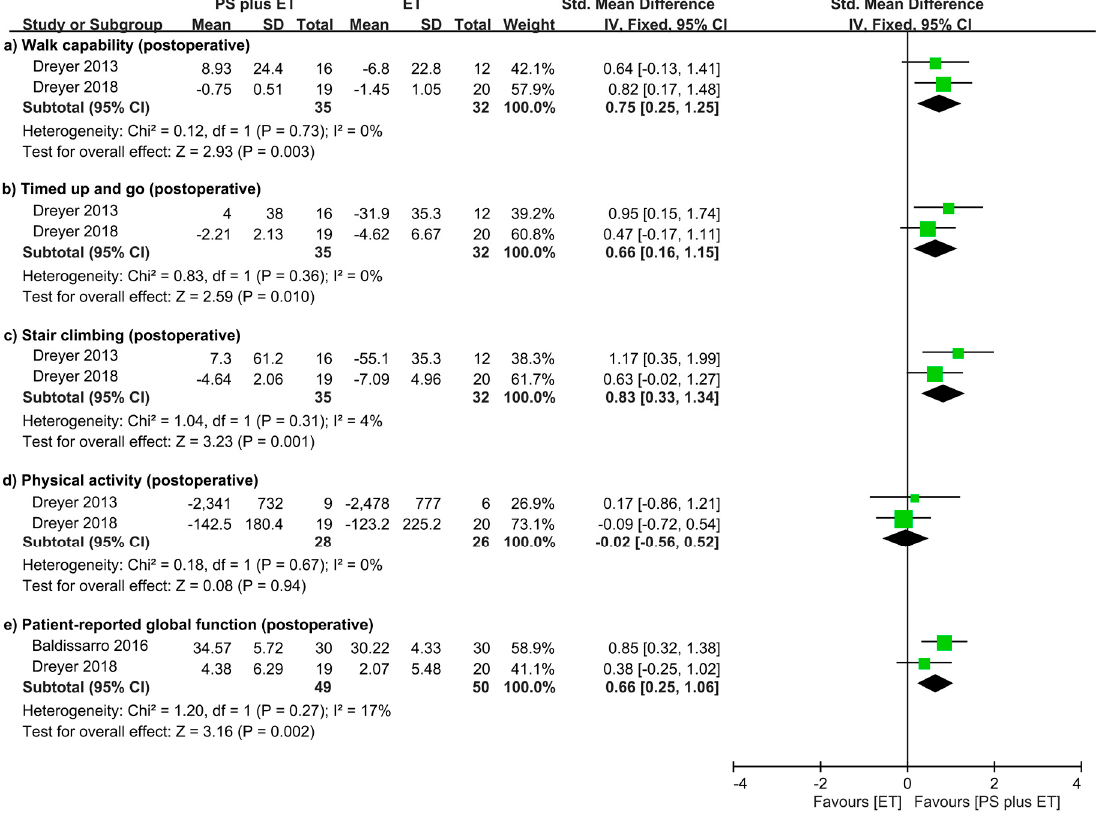
Figure 5. Forest plot summarizing the effects of postoperative protein supplementation (PS) plus exercise training (ET) on changes in ( a ) walking capability; ( b ) timed up-and-go performance; ( c ) stair climbing performance; ( d ) physical activity; and ( e ) global functioning over the overall follow-up period. The square represents the point estimate of the intervention effect for each trial. The horizontal line links the lower and upper limits of the 95% CI for the given effect. The area of the squares indicates the relative weight of the trials in the meta-analysis. Trial results plotted on the right-hand side of the vertical axis indicate effects in favor of protein supplementation. The combined effects are plotted using black diamonds. 95% CI, 95% confidence interval; Std, standard; IV, inverse varianc e.